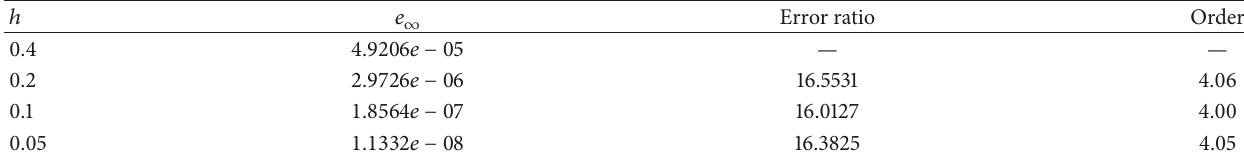
Table 1: The error, error ratio, and accuracy order computed by the CM-IIF2 scheme with 휏 = 10 −5 at time 푡 = 1 (Example 1).